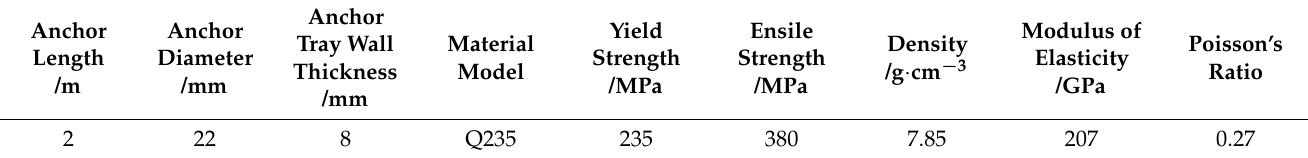
Table 1. The basic parameters of the conventional anchor rods.